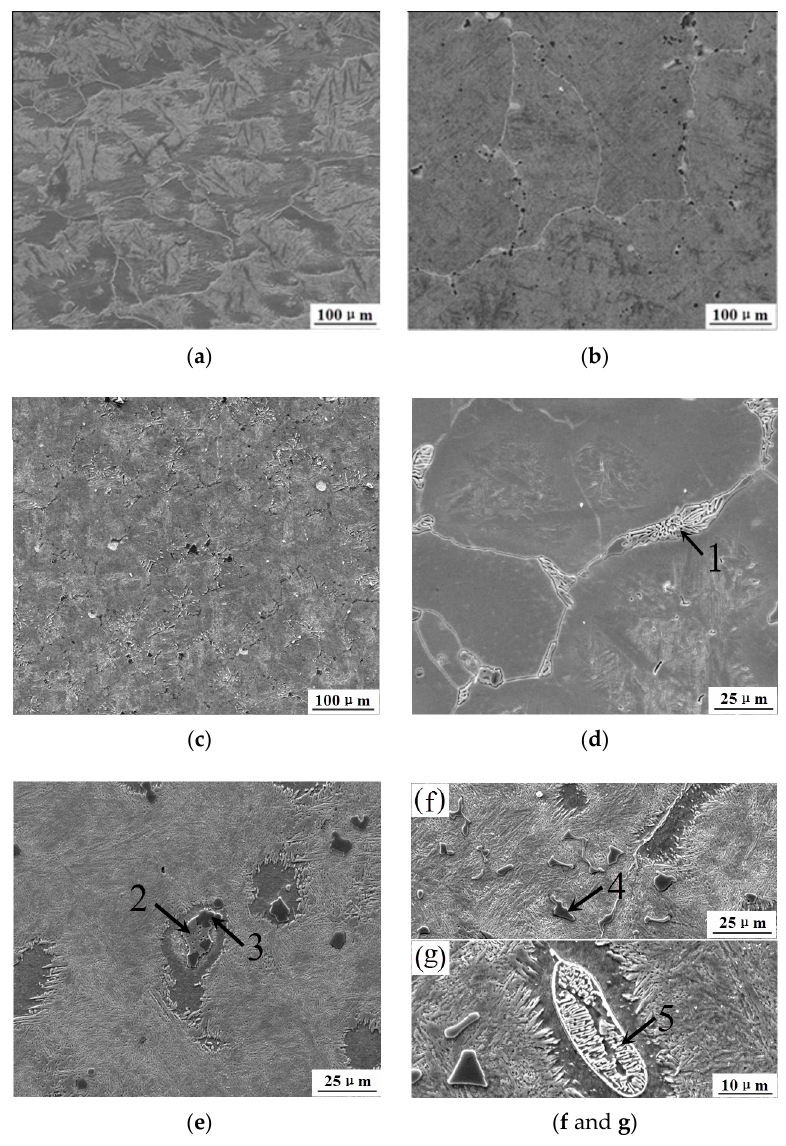
Figure 2. SEM images of as-cast ESR ingot microstructure: ( a ) and ( d ) sample No. 1; ( b ) and ( e ) sample No. 2; ( c ) and ( f ) and ( g ) sample No. 3. Table 2. The EDS results for carbides (mass %).